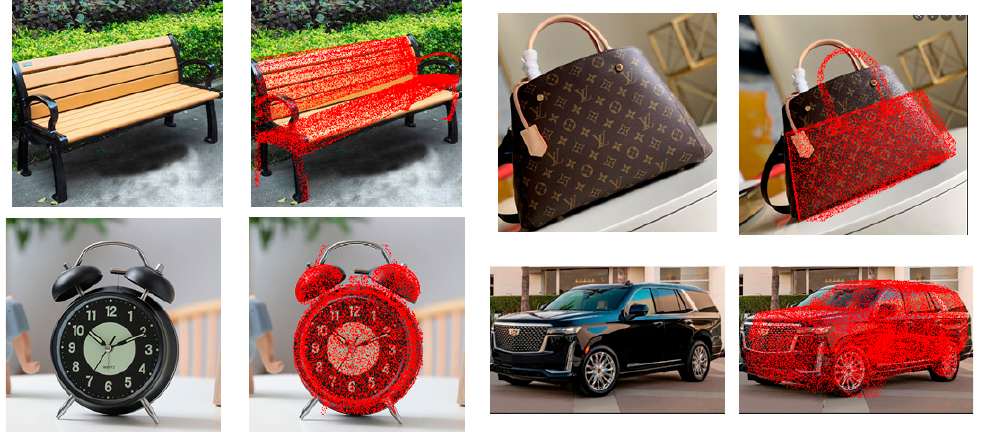
Figure 10. The matched CAD model is projected to the 2D image plane with the 4-DoF pose information. 4-DoF pose of the Clock and Car objects are very closely matched with the real objects. The Bench model projection is not perfectly matched with real object area due to a small pose error. The projection error of the Bag object CAD is caused by the shape mismatch between the real object and the CAD model.